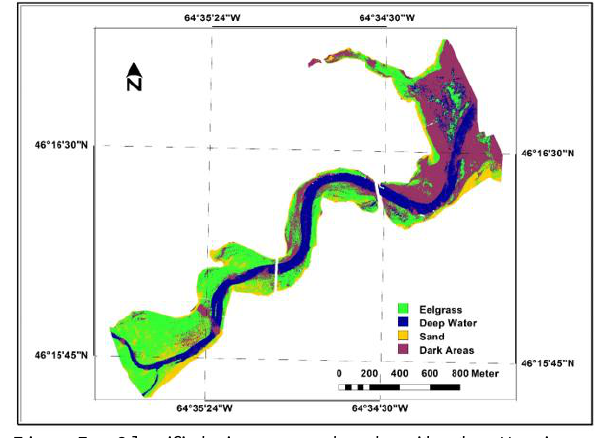
Figure 6: Channel 3 (red band) comparison of the DN values for the four classes in the Pix4D RGB mosaic of Shediac Bay.